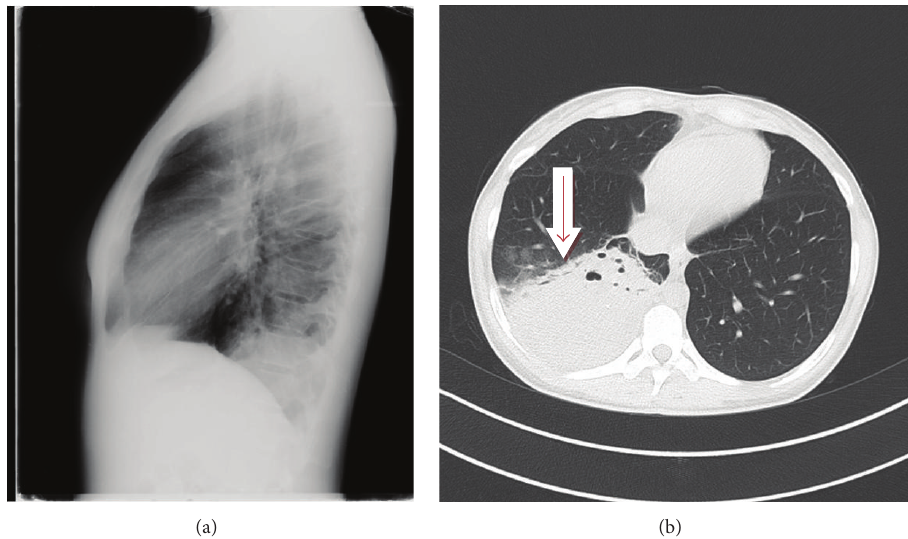
Figure 1: (a) Chest radiograph on presentation; (b) chest CT scanning on day 3 of admission, showing a large abscess in the right lower lobe.